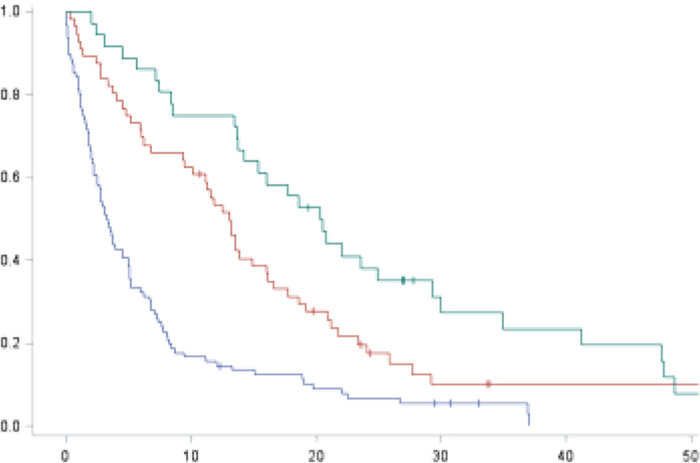
Kaplan Meier of survival of patients without systemic treatment (blue), with systemic treatment (red) or systemic treatment and bevacizumab (green).